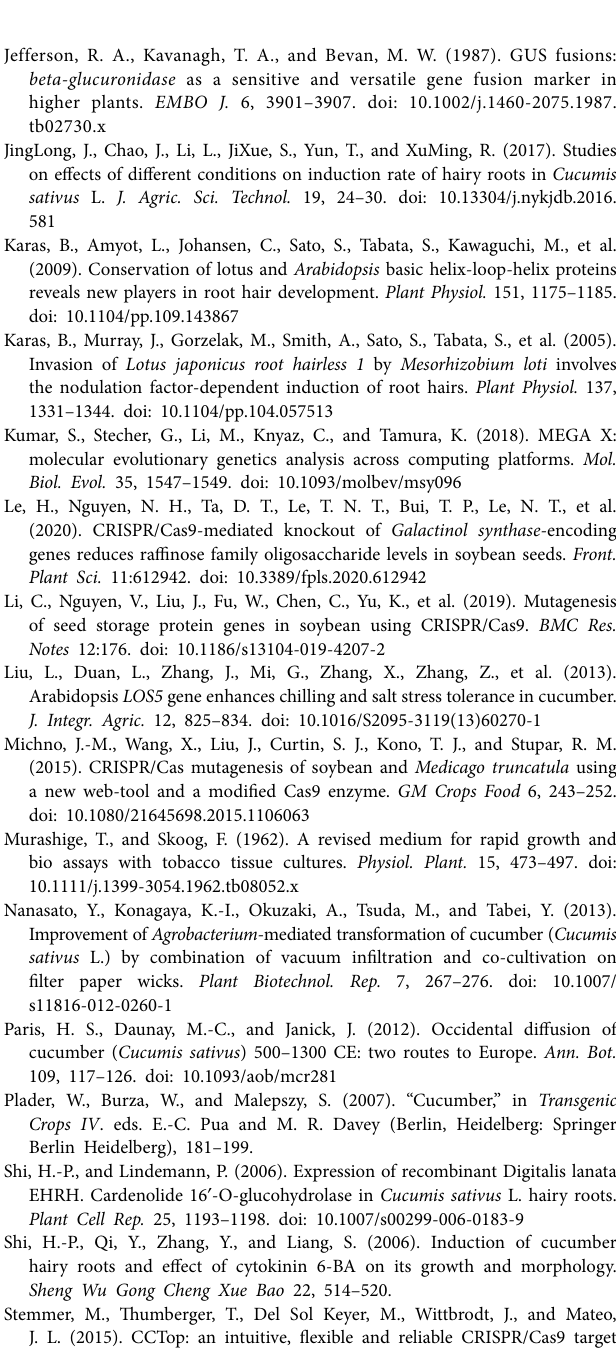
Supplementary Figure S4 | The stability of induced mutations in propagated cucumber hairy roots. (A) Heteroduplex analysis of CsbHLH66 gene. (B) Heteroduplex analysis of CsbHLH82 gene. M: 100 bp DNA Ladder; WT: wild type; P6 and P10: The original hairy roots of lines 6 and 10; 6-1, 6-1-1, 10-1, 10-1-1: Propagated roots from lines 6 and 10 at the second and third generations. (C,D) Expanding targeted sequences of CsbHLH82 and CsbHLH66 genes from propagated roots of the hairy root lines 6 and 10. Amplicon sequencings were conducted by the Sanger method. The expected sequences of mutant alleles were denoted upper chromatograms. (E) Clone sequencing of CsbHLH82 and CsbHLH66 targeted regions of propagated cucumber hairy roots at the third generation. Red and blue letters indicate target and PAM sequences, respectively. Green letters indicate inserted